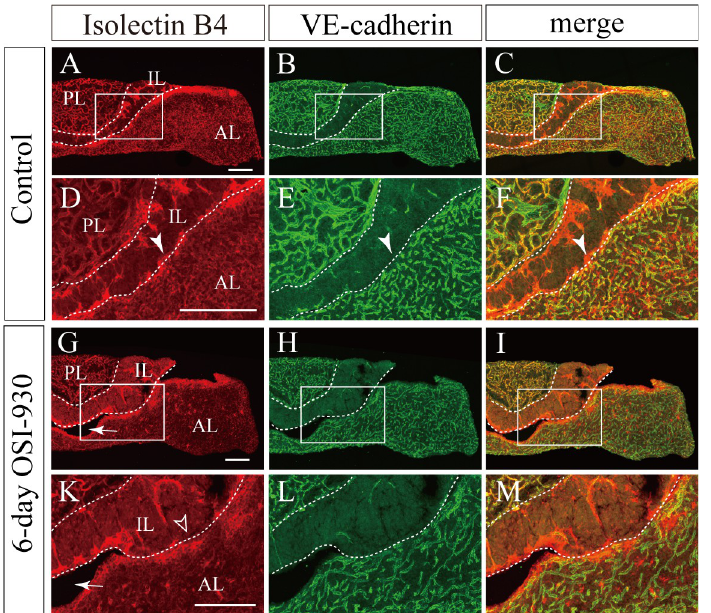
anterior lobe; IL, intermediate lobe; PL, posterior